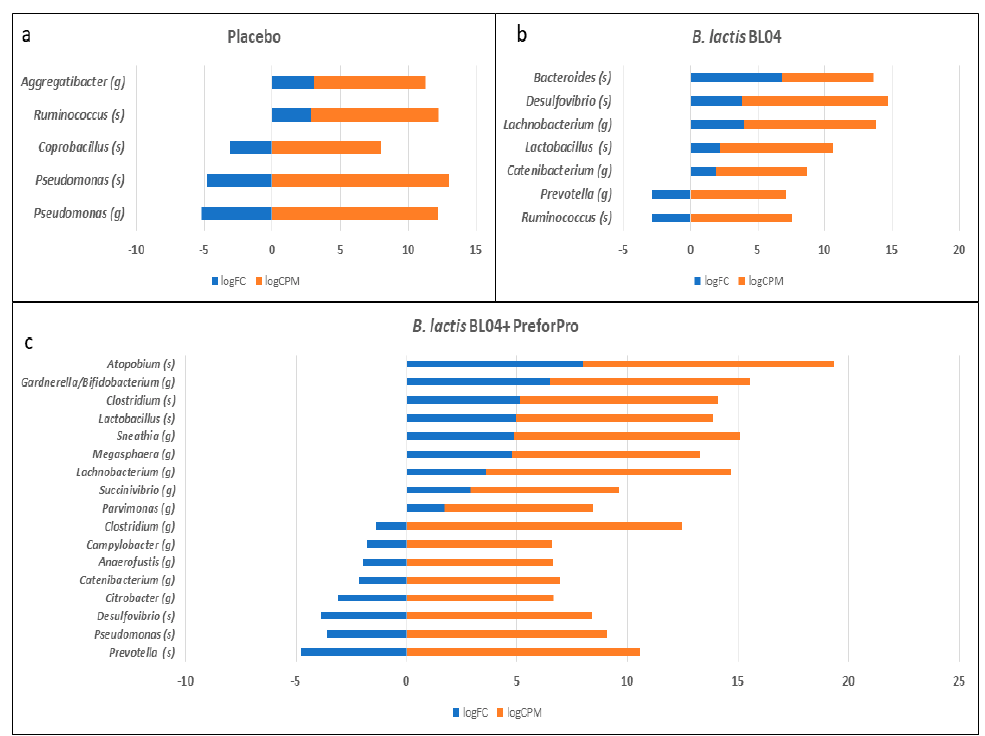
Figure 5. Changes in specific taxa within treatment groups, identified using a gene-wise negative binomial generalized linear model (EdgeR). ( a ) Placebo ( b ) lactis BL04 ( c ) lactis BL04 + PreforPro, Log Fold Change = logFC; log Count Per Million = logCPM.